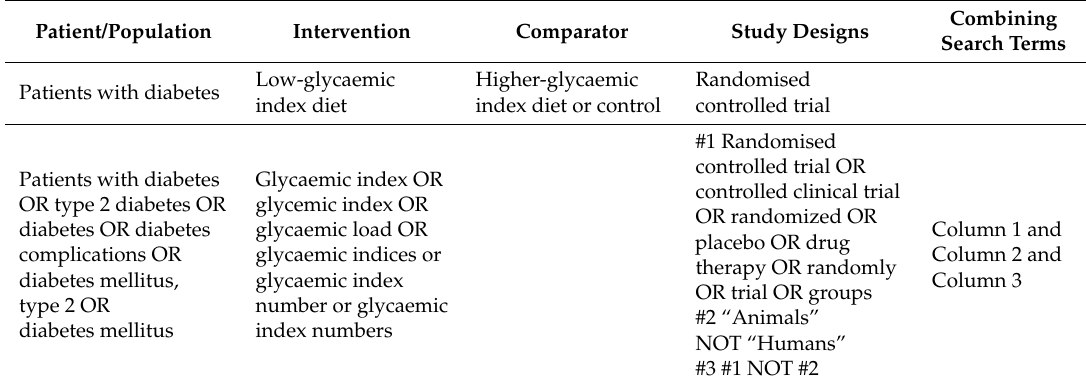
Table 1. Search terms and search